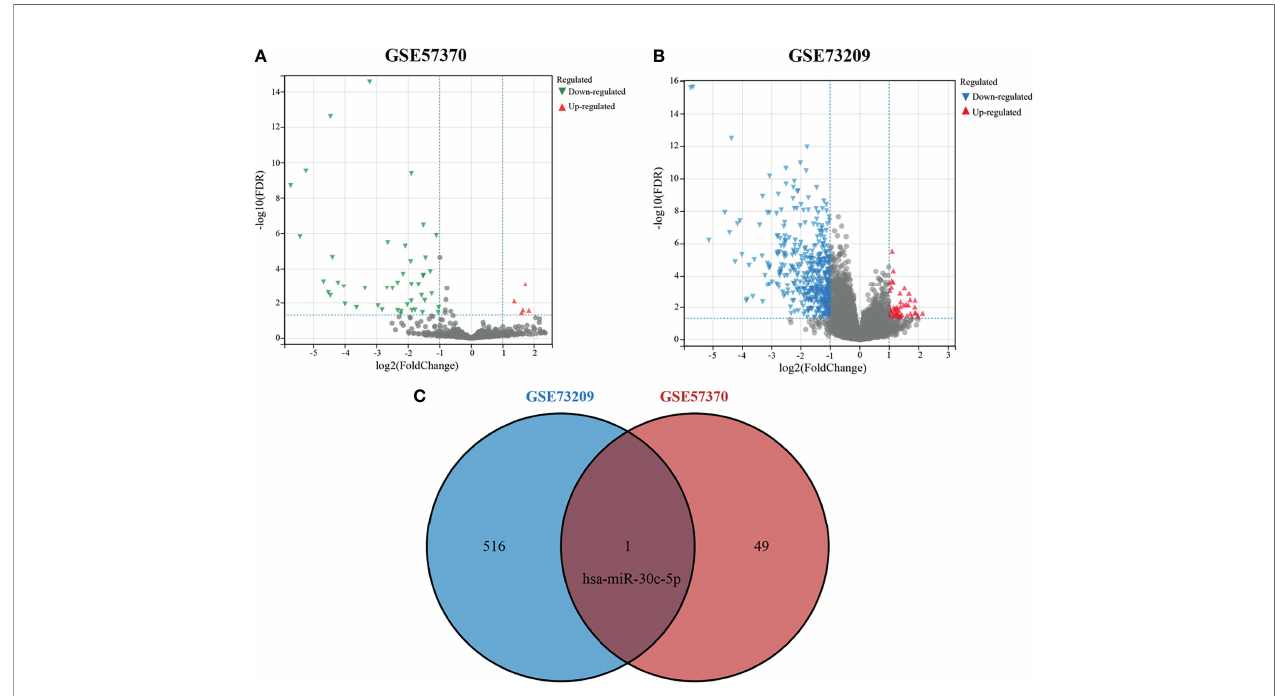
FIGURE 1 | Differentially expressed genes in Wilms tumor. (A) Volcano plot showing differentially expressed miRNAs in GSE57370; (B) Volcano plot showing differentially expressed genes in GSE73209; (C) Venn plot showing intersecting